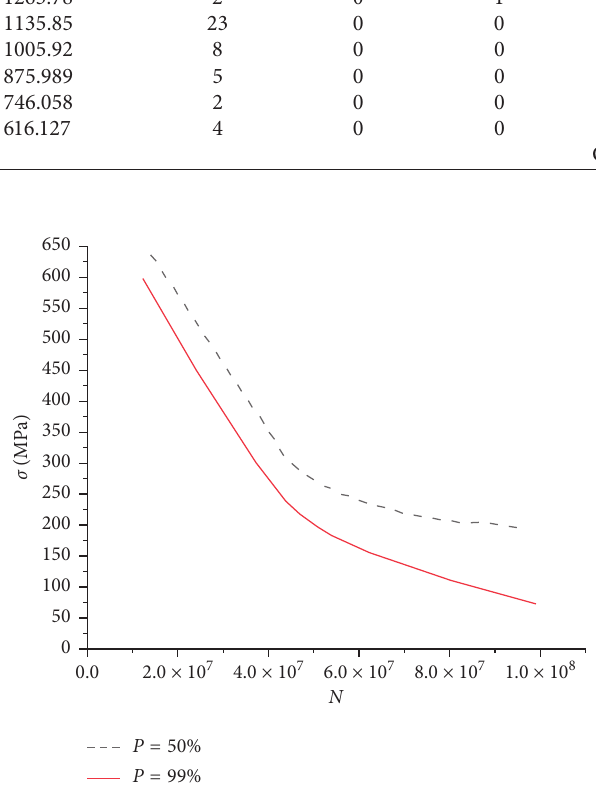
Figure 25: S-N curve of multi-wire recoil